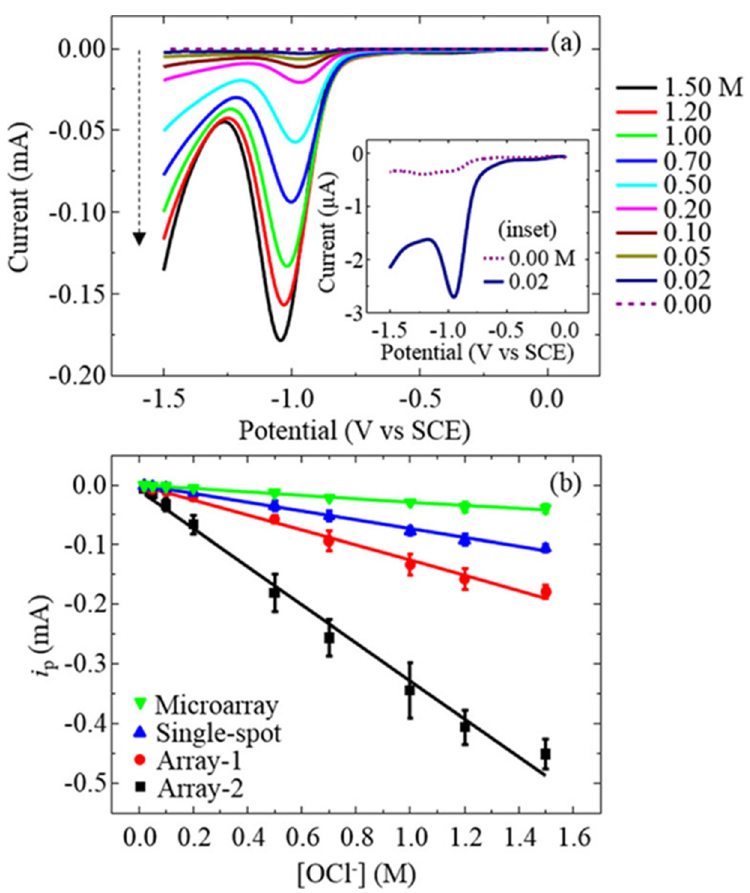
Figure 12. ( a ) Representative SWVs for the full concentration range (0.00 − 1.50 M OCl − ) using the array-1 electrode. The insets show the lowest concentrations examined. The dashed arrow points toward increasing OCl − concentrations. The SWV data is collected at 40 Hz with a perturbation amplitude of 0.05 V and data collection every 0.001 V (i.e., the effective scan rate is 0.04 V s − 1 ). ( b ) Background-subtracted peak currents from SWV data for all electrodes as a function of [OCl − ]. Error bars represent the sample standard deviation from n ≥ 3 measurements, and some error bars are contained within the symbols (reproduced with the permission of [111]).